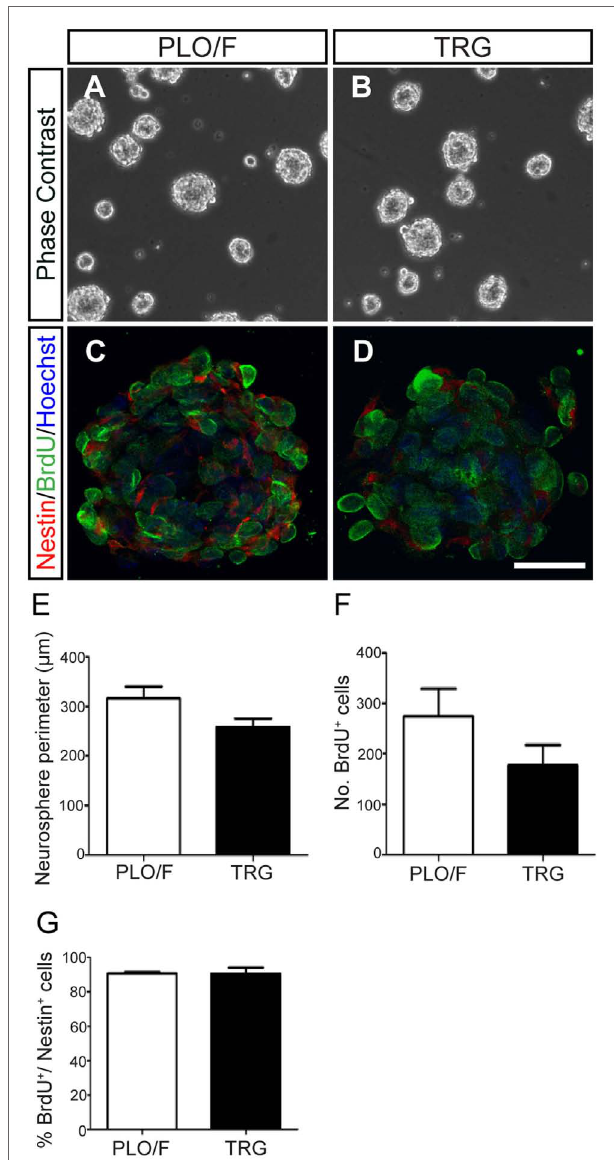
FigUre 2 | effect of Trg on the proliferation of aOBscs growing as neurospheres . The images show aOBSC neurospheres grown 3–4 days in culture on PLO/F control (a) and TRG coverslips (B) . Confocal photographs of neurosphere cross-sections (the center plane) after Nestin and BrdU immunostaining, and Hoechst nuclei counterstaining (c,D) . Although statistically not significant, there was a trend toward a decrease in neurosphere perimeter and in the number of BrdU + cells on TRG compared to the PLO/F controls (e,F) . The percentages of BrdU + cells over the total Nestin + cells were similar (g) . The bars represent the mean ± SEM ( n = 19 and 15 neurospheres for PLO/F and TRG) in (e) ; n = 3 for cultures for (F,g) . Statistical analyses were performed using the Student’s t -test. Scale bar [shown in (D) ] = 246.8 μ m (a,B) ; 30.1 μ m (c,D) .